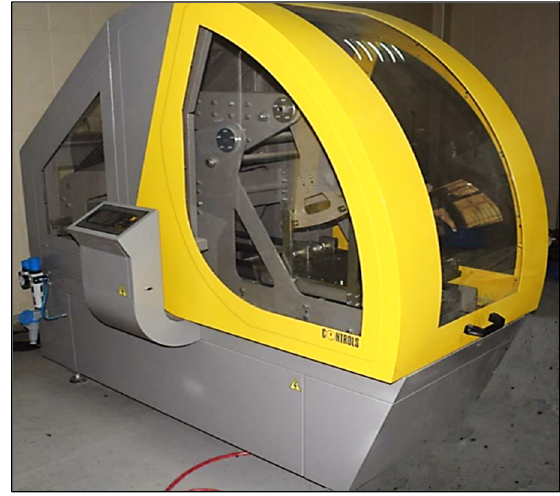
Figure 13. Samples pneumatic roller compactor.